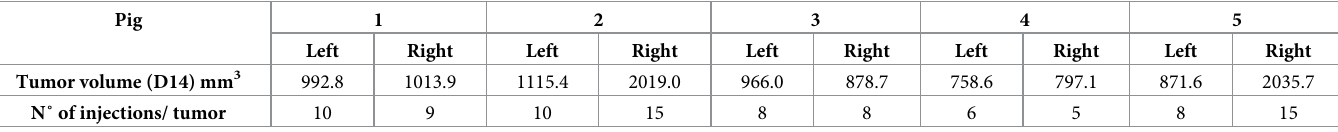
Table 2. Tumor volume (mm 3 ), measured based on CT-acquisition at day 14. The number of injections per tumor was different depending on both tumor shape and size. Pig 1 2 3 4 5 Left Right Left Right Left Right Left Right Left Right Tumor volume (D14) mm 3 992.8 N˚ of injections/ tumor